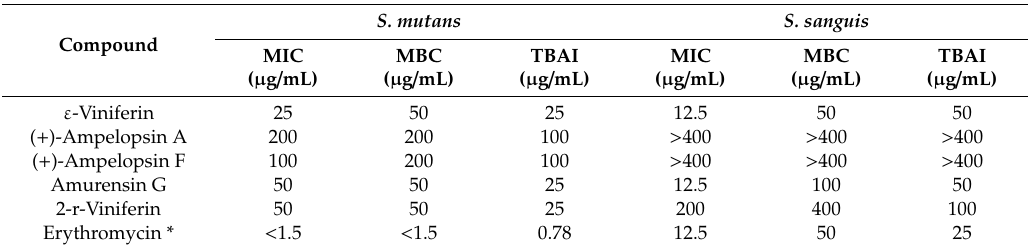
Table 15. MIC, MBC, and total bacterial adherence inhibition (TBAI) of the compounds from V. amurensis from Yim et al. (2010)